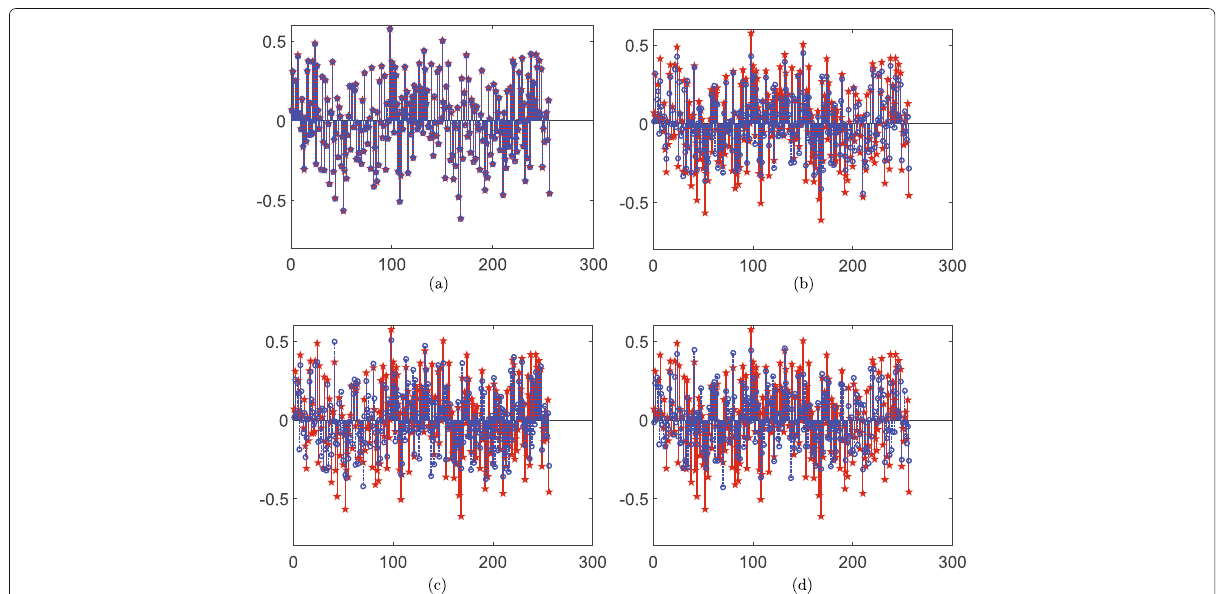
Fig. 3 An instance for recovering the signal, which can be expressed as a block 5-sparse vector in terms of (cid:4) for different recovery methods. The solid line with pentagram markers represent the original signal, and the dotted line represents the recovered signal. a (cid:2) 2 /(cid:2) 0.5 -analysis method. b /(cid:2) (cid:2) (cid:2) (cid:2) 2 1 -analysis method. c 0.5 -analysis method. d 1 -analysis method